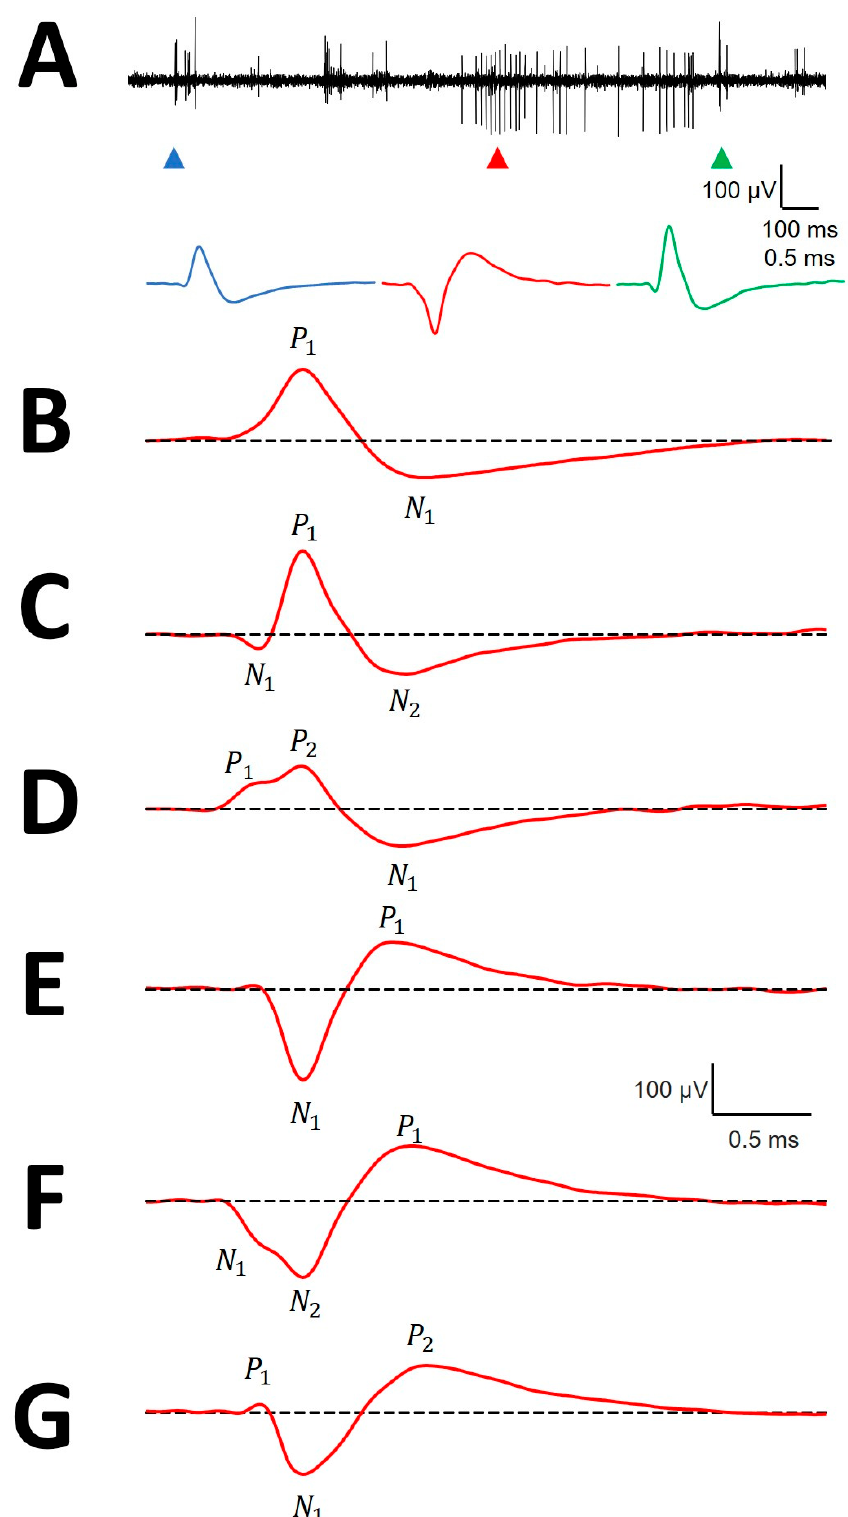
Figure 2. Canonical forms of mAPs. ( A ) Simultaneity of positive and negative extracellular action potentials. Upper row: raw trace containing upward and downward directed potentials; bottom row: AP corresponding to the upper arrowheads. Each colored P corresponds to the same color arrowhead. ( B ) P1N1; ( C ) N1P1N2; ( D ) P1P2N1; ( E ) N1P1; ( F ) N2N2P1 and ( G ) P1N1P2. The dashed line indicates the basal voltage. Positive ( P ) and negative ( N ) phases are indicated.